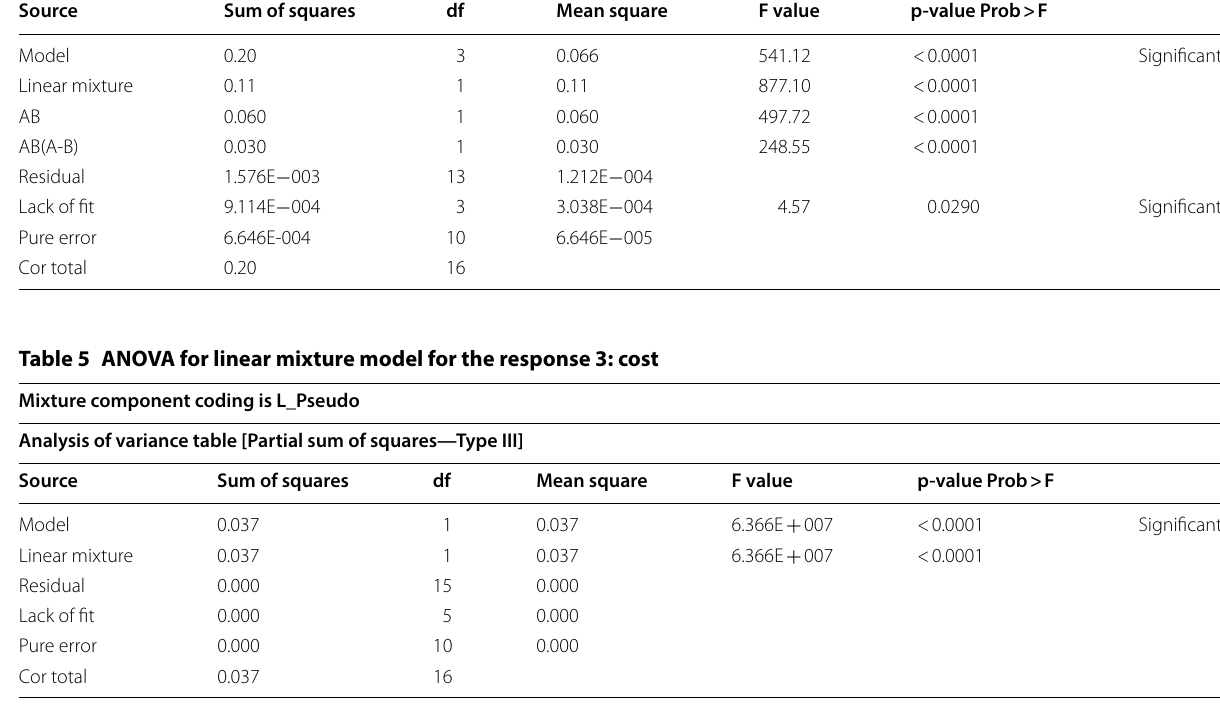
Table 4 ANOVA for Cubic Mixture Model for the response 2: µ Mixture component coding is L_Pseudo Analysis of variance table [Partial sum of squares—Type III] Source